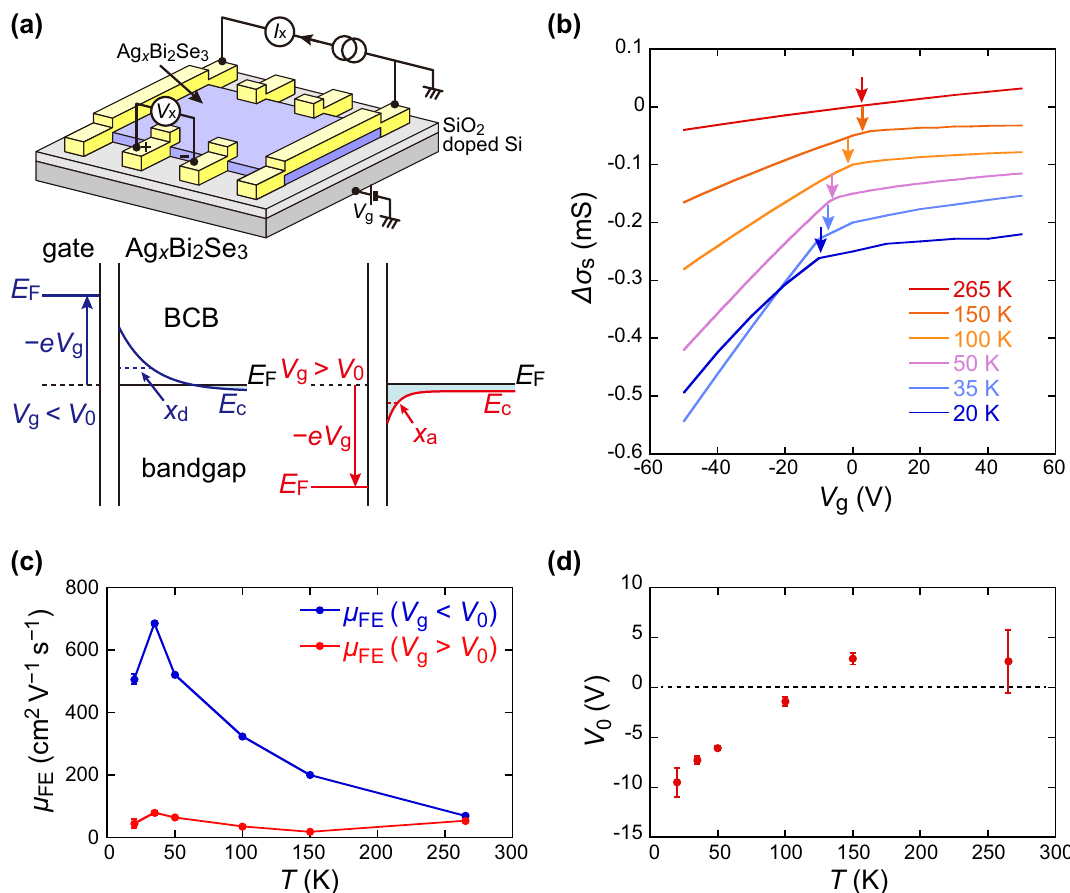
Figure 4. ( a ) Schematic configuration for field-effect measurement, and band diagram at the interface between gate electrode/gate insulator/Ag x Bi 2 Se 3 . The Fermi energy E F of Ag x Bi 2 Se 3 is assumed to be located immediately above the bottom of BCB. The conduction band minimum of Ag x Bi 2 Se 3 , E c , under negative and positive V g is indicated with blue and red lines, respectively. Note that depletion depth x d is much larger than accumulation depth x a . ( b ) Gate voltage dependence of sheet conductivity of sample #2 at various temperatures. The curves are offset for clarity. The arrows indicate the inflection points. ( c ) Temperature dependence of field-effect mobility evaluated from V g < V 0 (blue line) and V g > V 0 (red line). ( d ) Temperature dependence of the inflection point, V 0